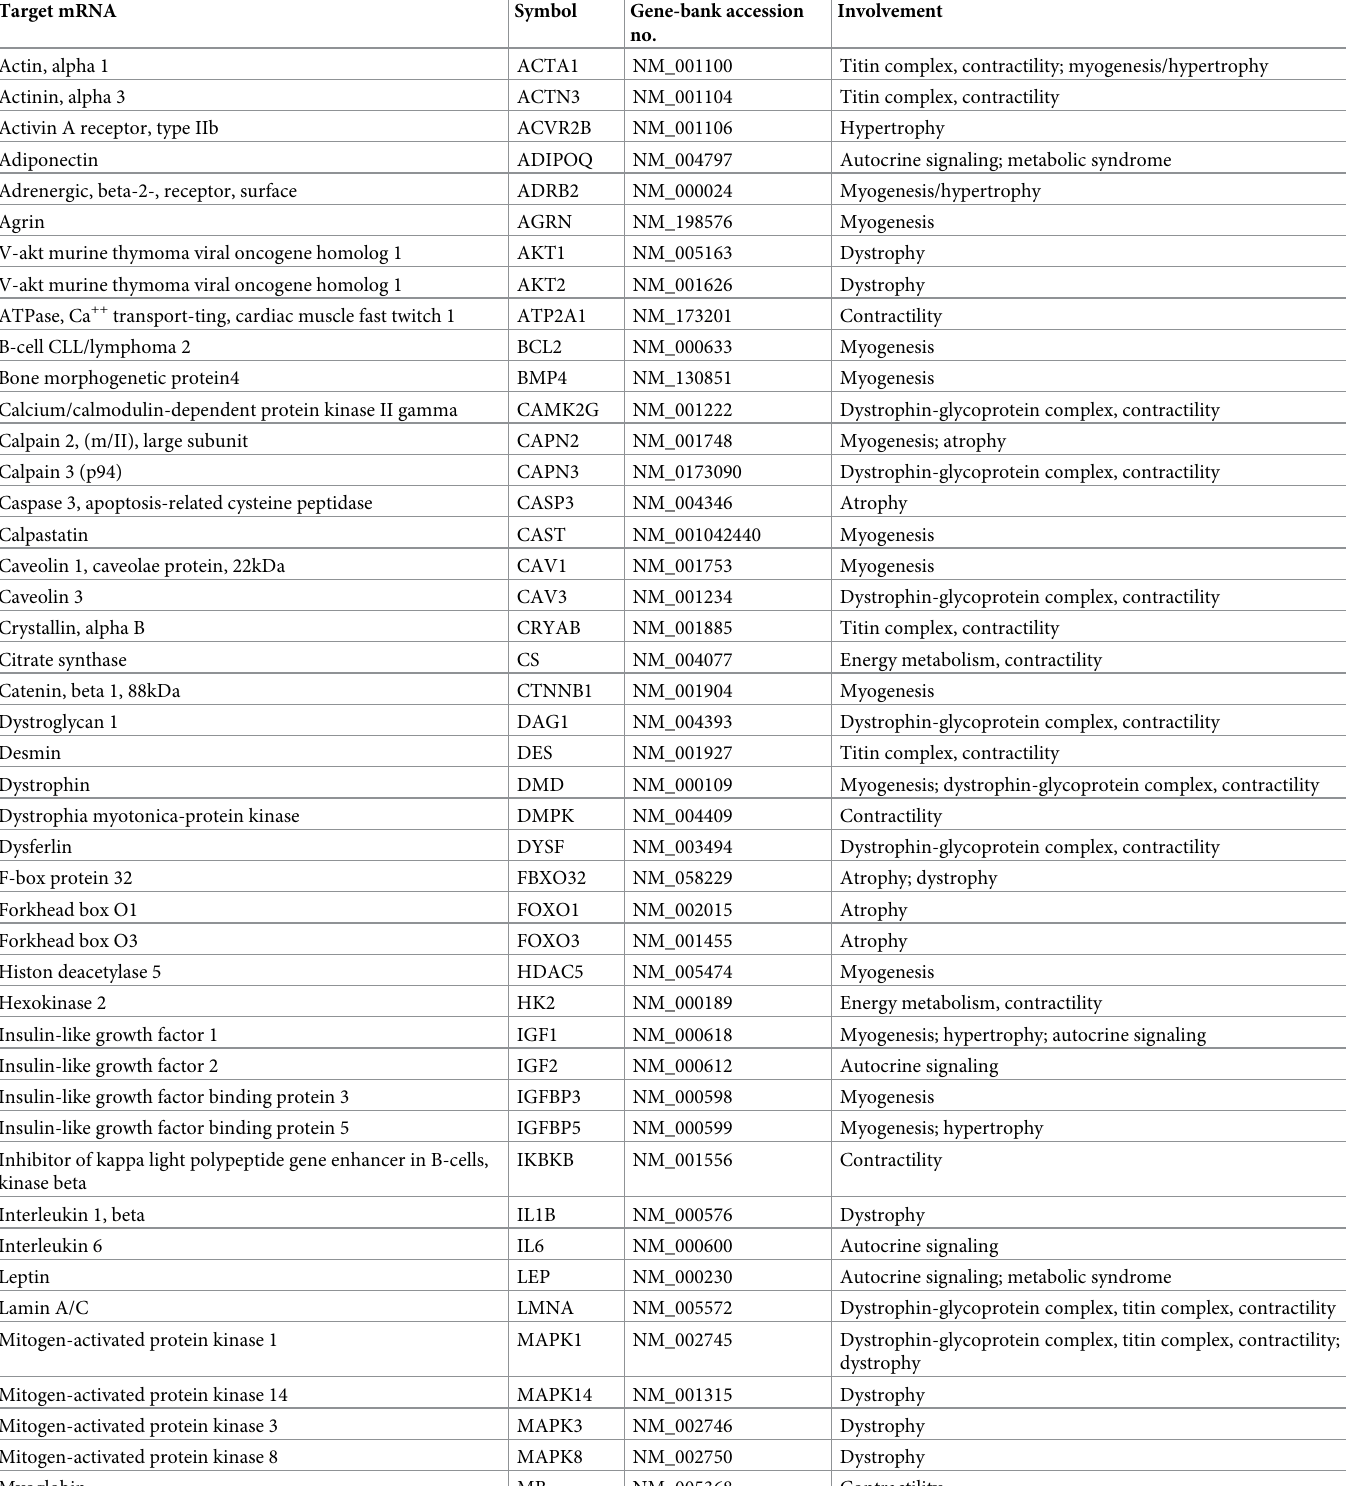
Table 1. RT 2 Profiler TM PCR array human skeletal muscle: Myogenesis &